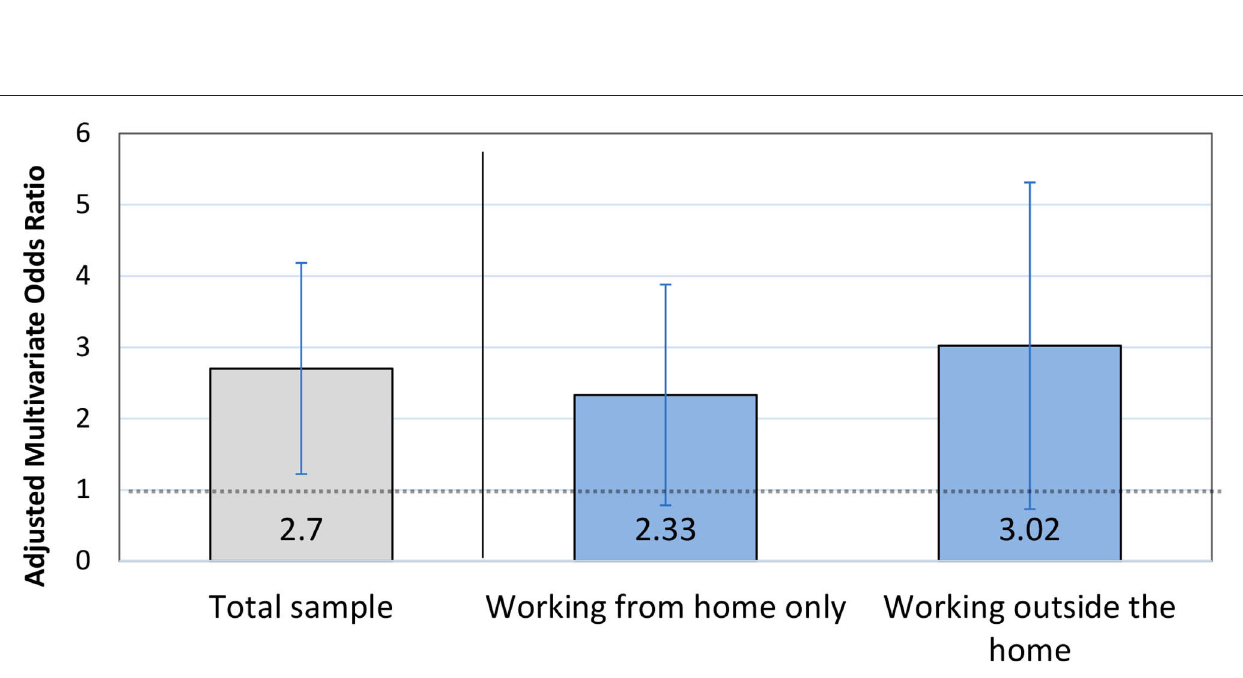
Frontiers in Global Women’s Health |